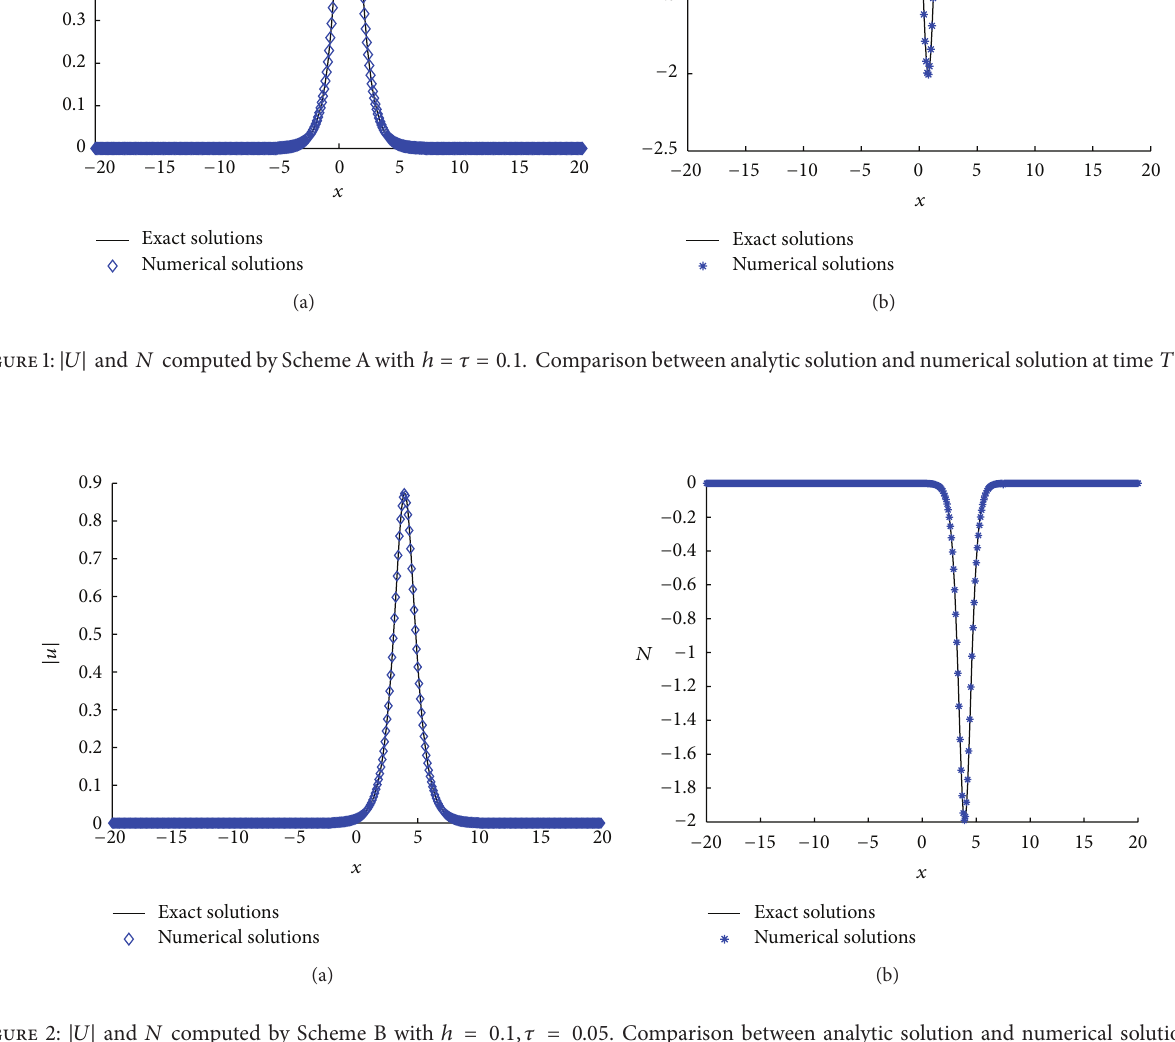
Figure 2: |𝑈| and 𝑁 computed by Scheme B with ℎ = 0.1, 𝜏 = 0.05. Comparison between analytic solution and numerical solution at time 𝑇 = 5